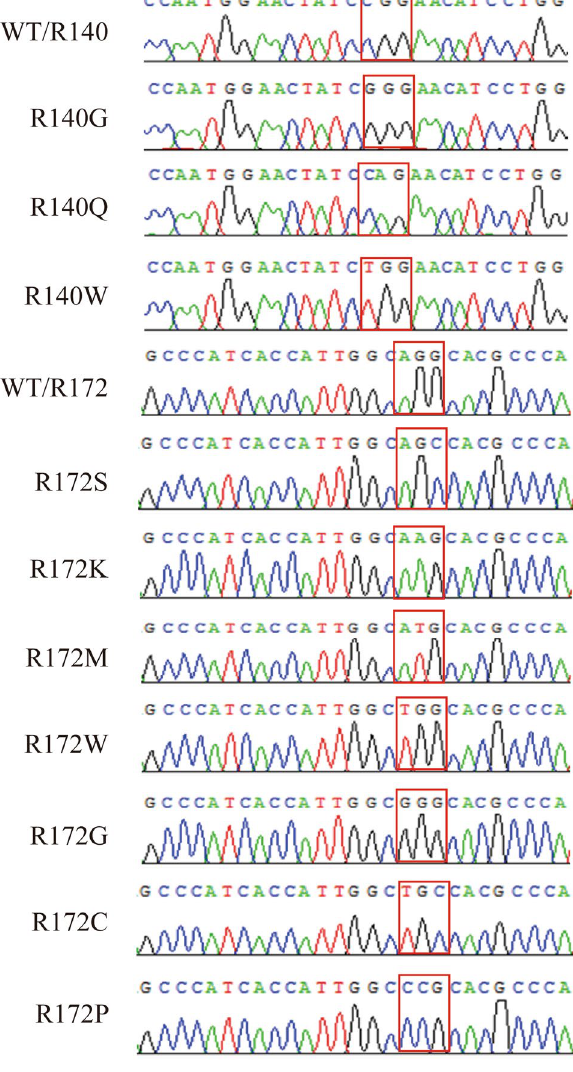
Figure 1. Analysis of the recombinant IDH2 wild-type and mutant sequences. The sequences of wild-type, R140-mutated and R172-mutated IDH2 were corrected by BLASTing against